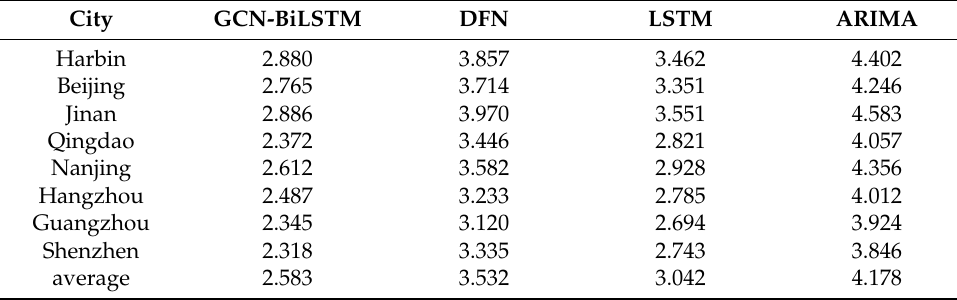
Table 9. Comparison of MAE for multiregional temperature